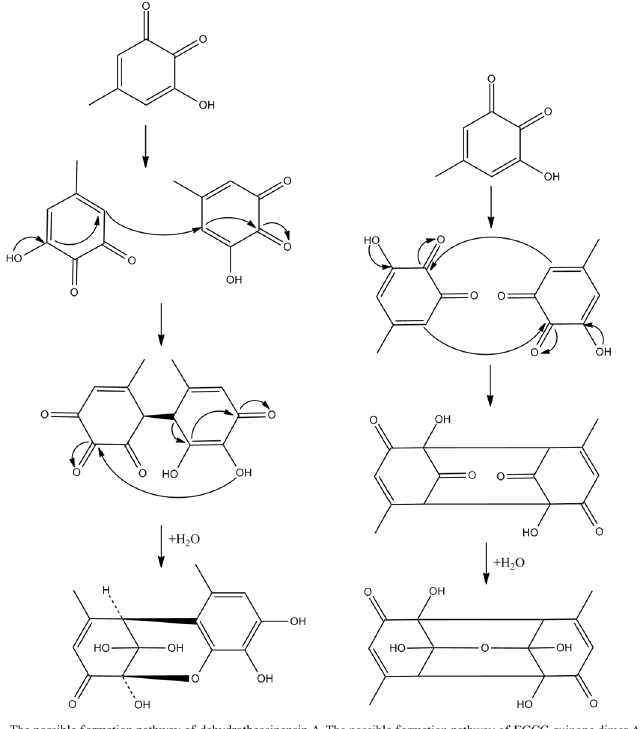
Figure 9. The possible mechanism for the formation of dehydrotheasinensin A and EGCG quinone.